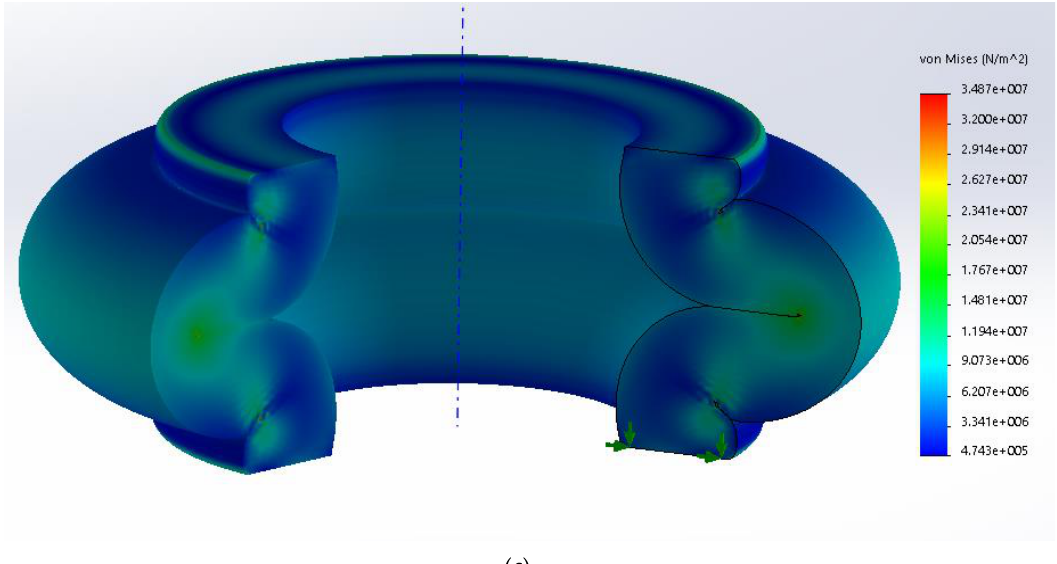
Figure 7. ( a ) Comparison of the experimental stress–strain curve of the rubber fender under tensile loading and the fitted one obtained from the Mooney–Rivlin model. Finite element analysis results for the stress distribution contour of the rubber fender with wall thicknesses values of ( b ) 25.0 and ( c ) 15.0 mm under a maximum compression displacement of 50 mm.